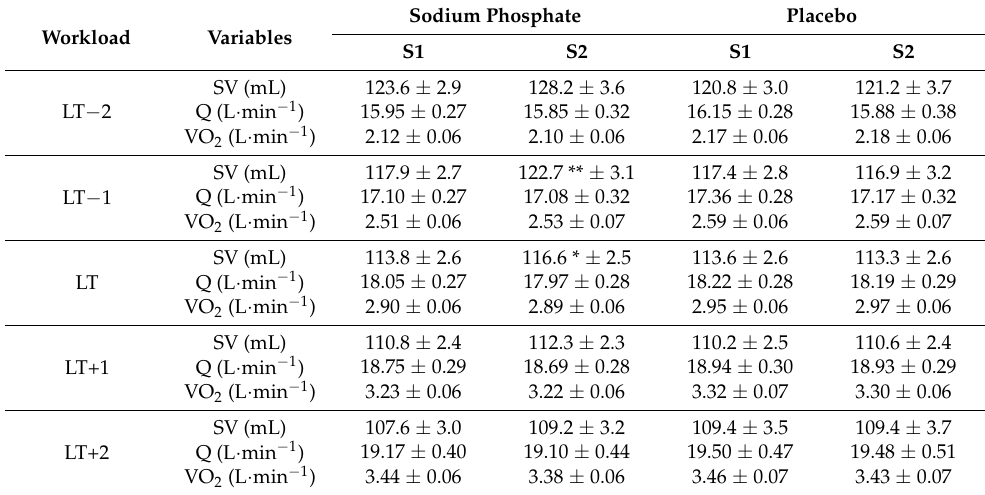
Figure 3. Oxygen pulse (VO 2 /HR) during exercise in hypoxia before (S1) and after (S2) sodium phosphate ( A ) and placebo ( B ) ingestion. * p < 0.05 S1 vs. S2. LT − 2, LT − 1, LT, LT+1, LT+2—absolute workload corresponding to workload at lactate threshold (LT) as well as one and two workloads below and above LT which were determined during the initial exercise test (S1). Table 2. Stroke volume (SV), cardiac output (Q) and oxygen uptake (VO 2 ) during exercise in hypoxia before (S1) and after (S2) sodium phosphate and placebo supplementation.